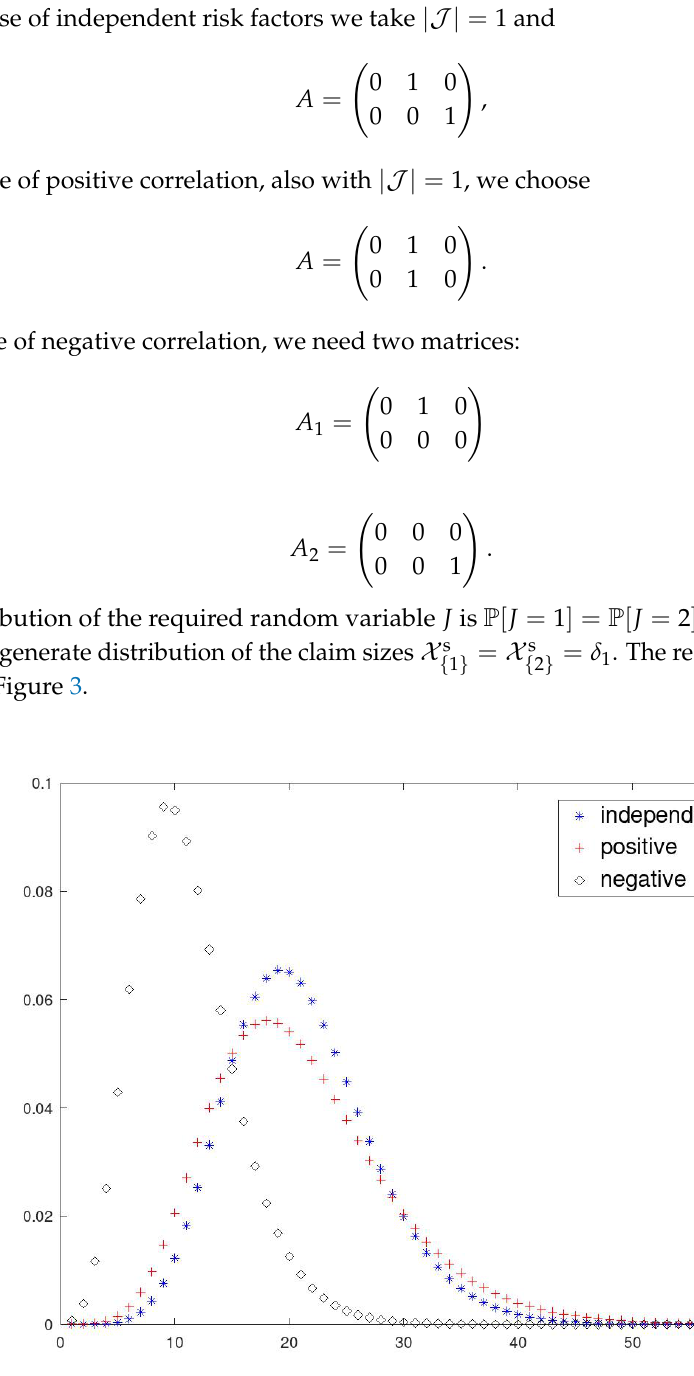
Figure 3. Probability mass functions of the N 0 -valued portfolio loss ˆ S for different dependence structures for the two claim cause intensities Λ 1 and Λ 2 . We take V = R . The claim size equals = X s = δ 1 in all cases, i.e., X s 1 2 1